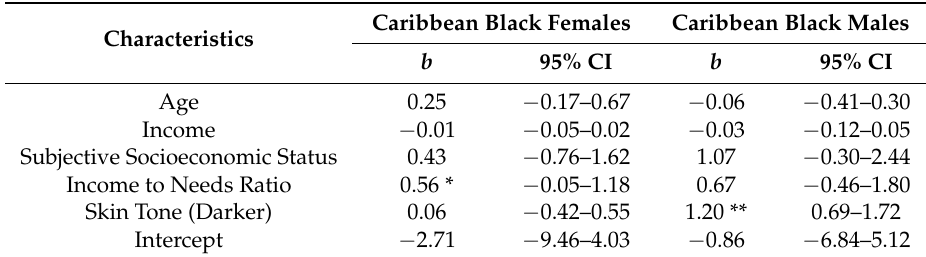
Table 4. Linear regressions in male and female Caribbean Black